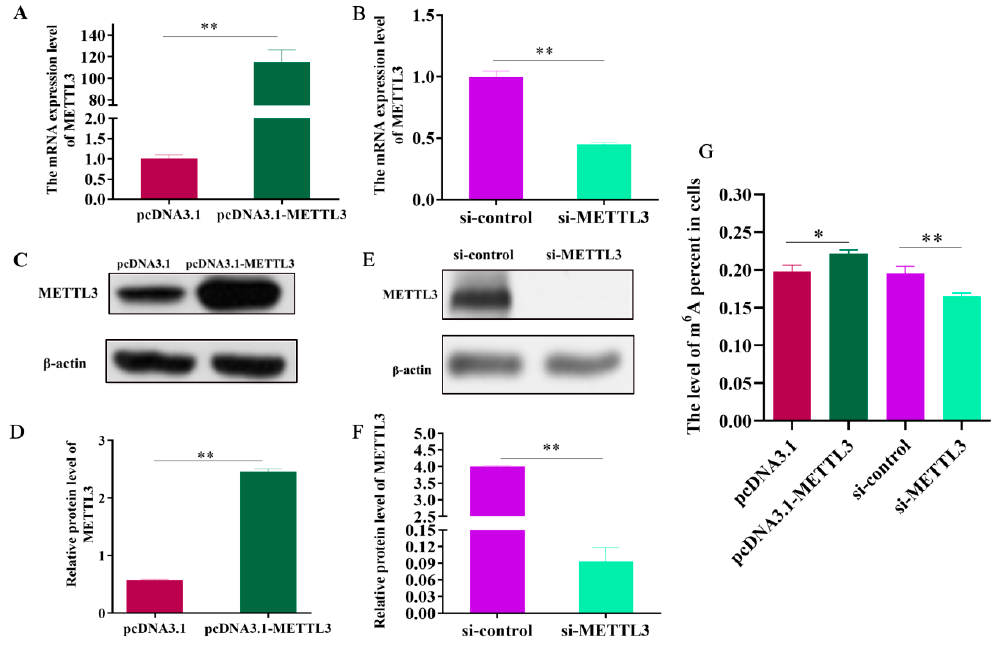
Figure 2. The effect of METTL3 on m6A methylation levels in IPEC-J2 cells. The expressions of METTL3 mRNAs ( A , B ) and Western blotting ( C – F ) after METTL3 knockdown or overexpression in IPEC-J2 cells. ( G ) IPEC-J2 cell m6A content following METTL3 overexpression and knockdown. All data are based on three separate trials presented as mean ± SD. ** p < 0.01 and * p < 0.05, re- spectively.